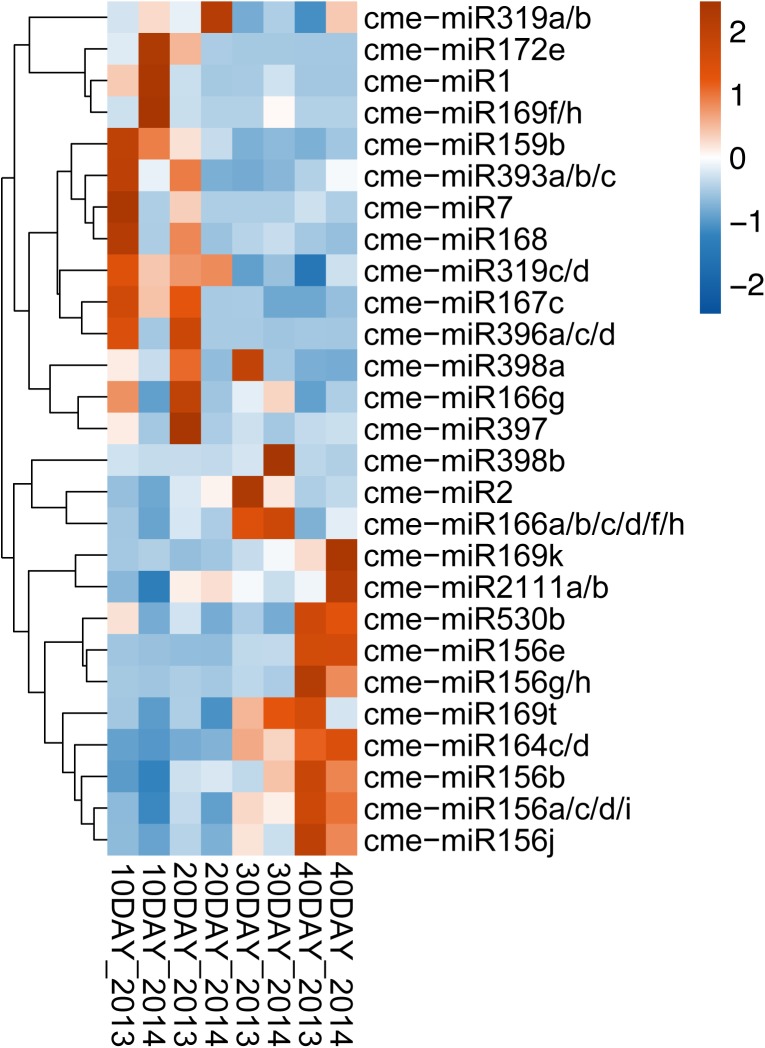
Differentially expressed Hami melon miRNAs during fruit development.The heatmap illustrates the expression profiles of differentially expressed miRNAs (log2TPM, y-axis) at the four developmental stages (x-axis). Colors range from blue to red, corresponding to low to high expressions. DAF represents days after flowering. 2013 represents the first batch samples collected in 2013. 2014 represents the second batch samples collected in 2014.